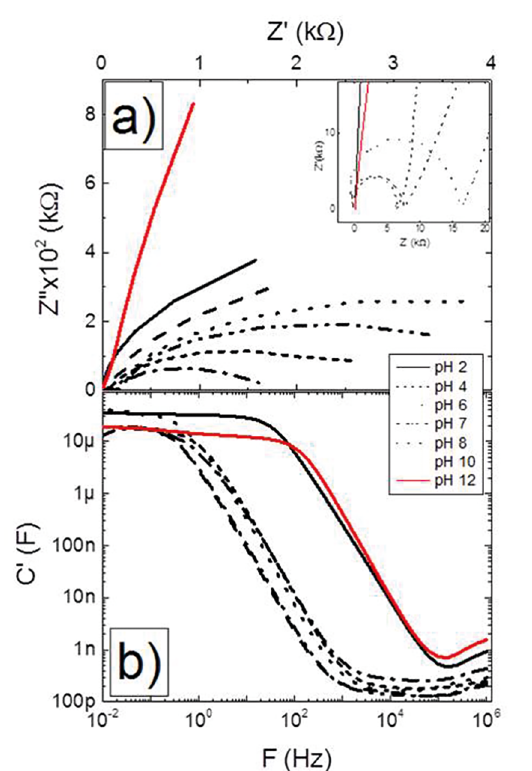
Figure 7. a) Spectroscopy impedance results. Nyquist diagram for FTO sample in different pHs (2, 4, 6, 7, 8, 10 an 12). b) Capacitance Diagram for a typical FTO sample.